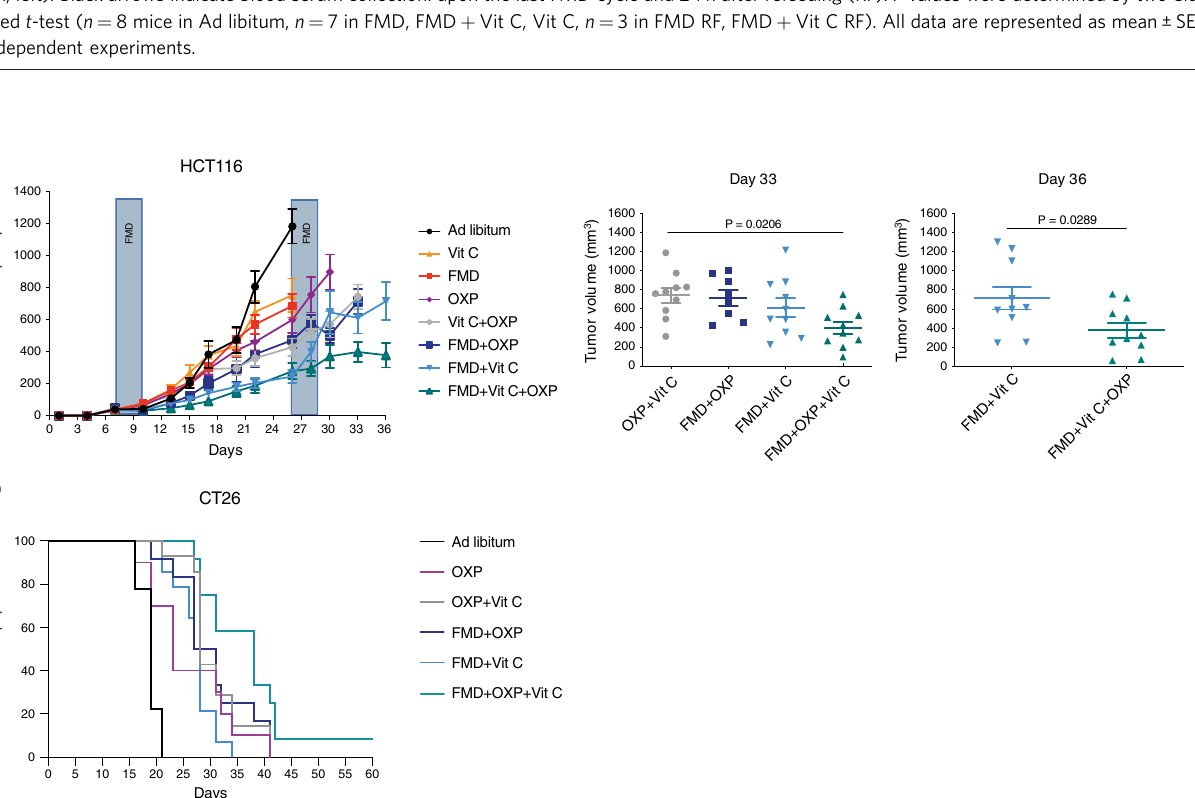
Fig. 5 FMD, vitamin C and OXP triple treatment delays tumor progression and extends survival. NSG and BALB/c mice were subcutaneously injected with HCT116 cells and CT26 cells, respectively. Mice were fed ad libitum or subjected to FMD cycles, and treated with or without vitamin C or oxaliplatin (10 mg/kg). a HCT116 tumor progression (left) and volume at day 33 and 36 (right), respectively ( n = 10 in Ad libitum, FMD, FMD + Vit C, Vit C + OXP, FMD + Vit C + OXP, n = 8 in FMD + OXP, n = 9 in OXP, n = 11 in Vit C). P values were determined by One-way ANOVA with Tukey ’ s post analysis (day 33) and two-sided unpaired t -test (day 36). Data are represented as mean ± SEM. b BALB/c with CT26 survival curves ( n = 9 in Ad libitum, n = 10 in OXP, n = 12 in FMD + OXP and FMD + OXP + Vit C, n = 14 in OXP + Vit C and FMD + Vit C). P values were determined by Log-rank (Mantel-Cox) test (Ad libitum vs OXP, p = 0.0040; OXP vs FMD + Vit C, p = 0.7177; OXP vs FMD + OXP + VitC, p = 0.0114; FMD + OXP vs FMD + OXP + Vit C, p = 0.0488; OXP + Vit C vs FMD + OXP + Vit C, p = 0.0345; FMD + OXP + Vit C vs FMD + Vit C, p = These data, together with additional published and ongoing clinical studies, indicate that FMD cycles in combination with a variety of therapies could represent a promising non-toxic strat- egy for the treatment of different cancer types, paving the way for conducting clinical trials to test FMD plus vitamin C in combi- nation with standard of care for the treatment of KRAS -mutant cancers. Methods Cell lines and culture conditions . HCT116, HT29, NCI-H23, and PC-3 cells were obtained from NCI 60 panel; CT26 and CCD84CoN cells were purchased from ATCC; DLD1 cell line was purchased from DSMZ; SW48, NCI-H727, PANC-1, and COV362 cells were purchased from ECACC. SW48 KRAS G12D/ + cell lines were purchased from Horizon. CT26-luc cells for in vivo experiment were